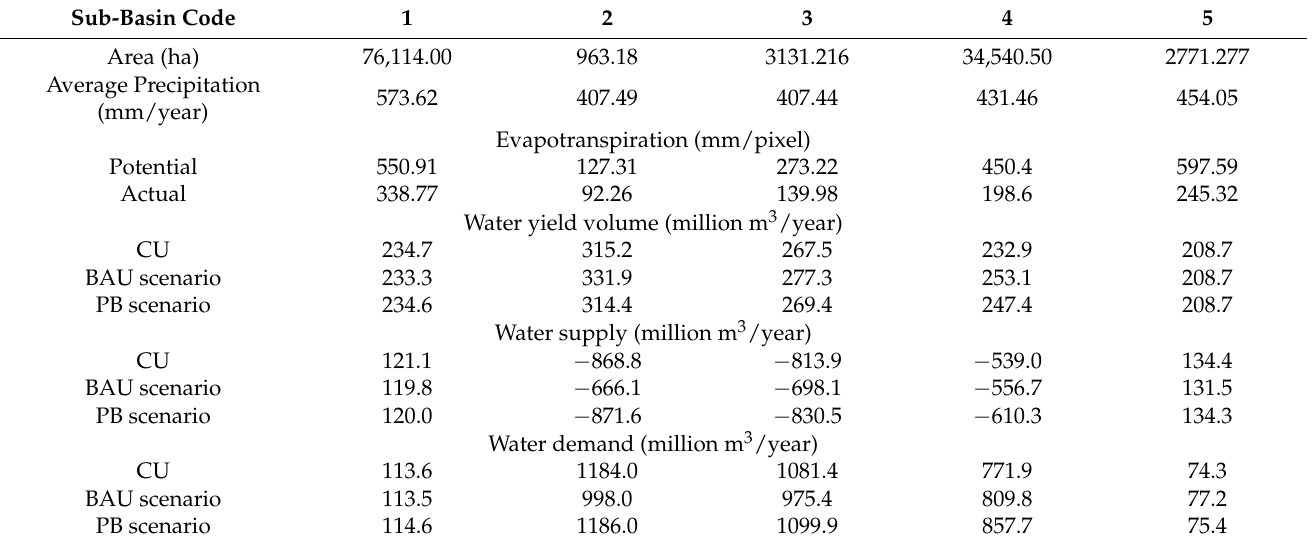
Table 5. The volume of water production and other related variables in the water basins in the Karaj